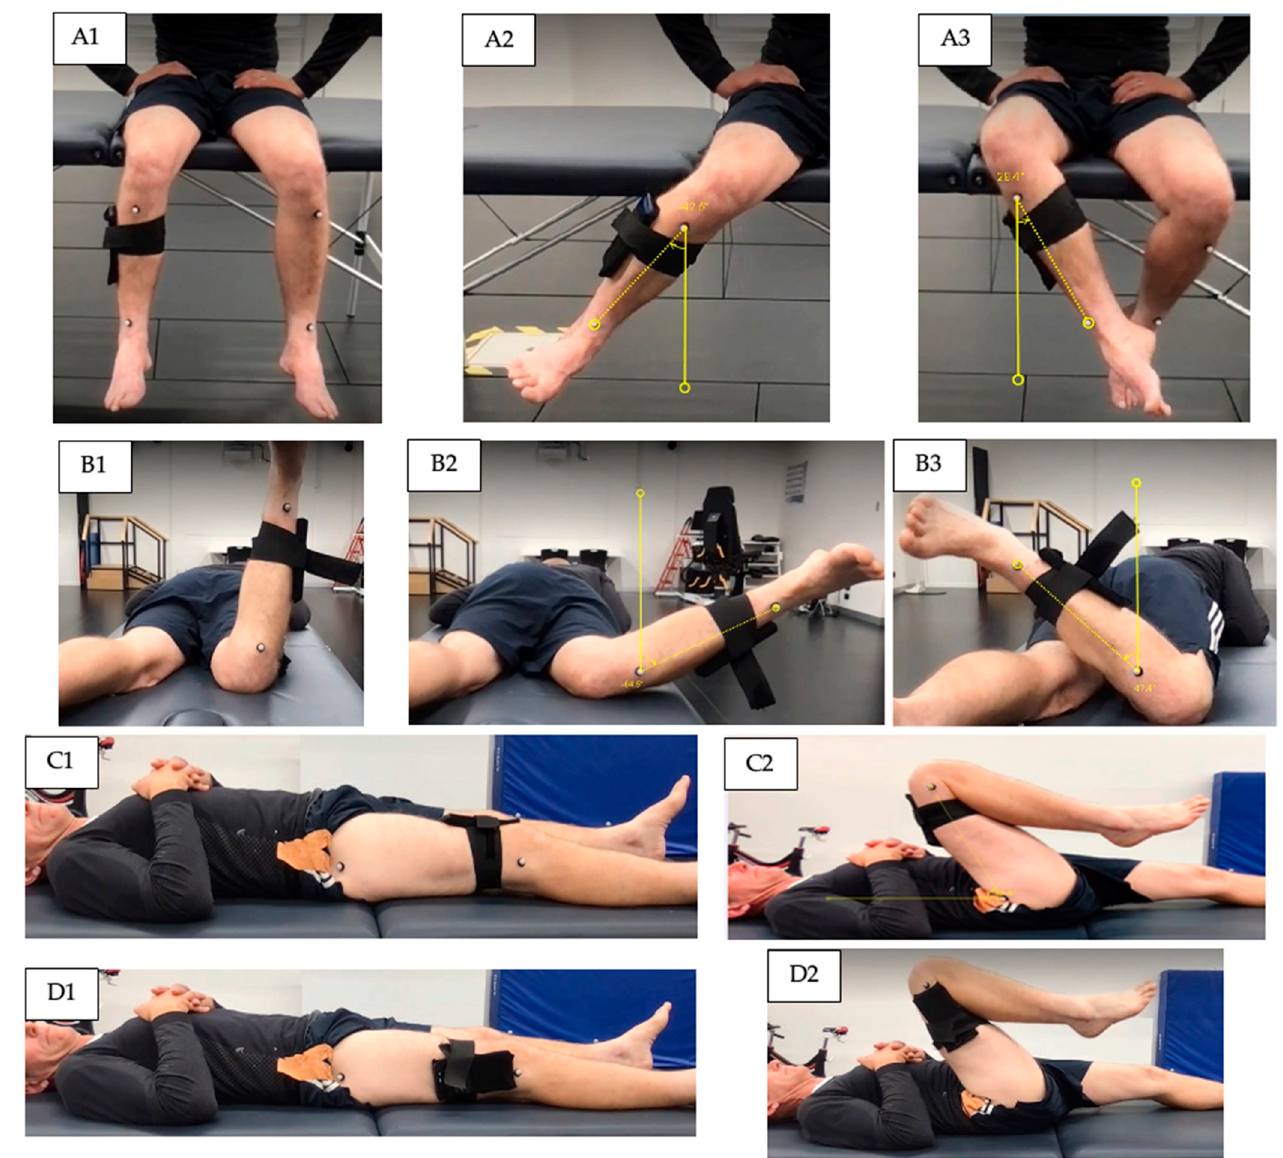
Figure 1. Range of motion measurements using the TelePhysio app, 2D video recording and analysis tool, and 3D motion capture reflective marker system. Starting positions ( A1 , B1 , C1 , D1 ). Hip internal rotation sitting ( A2 ) and prone ( B2 ). Hip external rotation sitting ( A3 ) and prone ( B3 ). Hip flexion with smartphone anterior ( C2 ) and lateral ( D2 ) position.